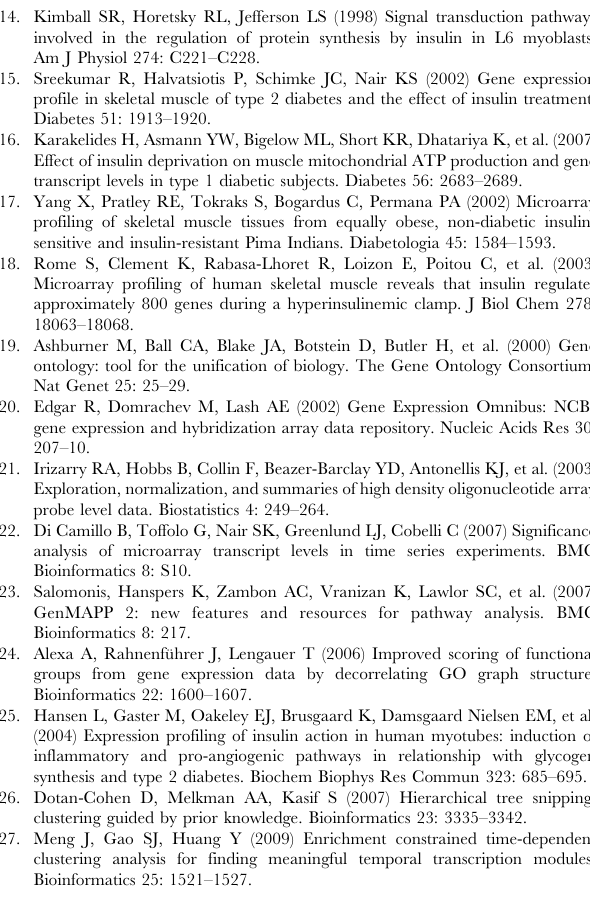
Table S1 A detailed list of selected genes, their annotation with the GO molecular function term and the associated patterns. Table S2 A complete list of annotated genes along with the information on the selected genes, gene ontology terms and differential expression data associated to each